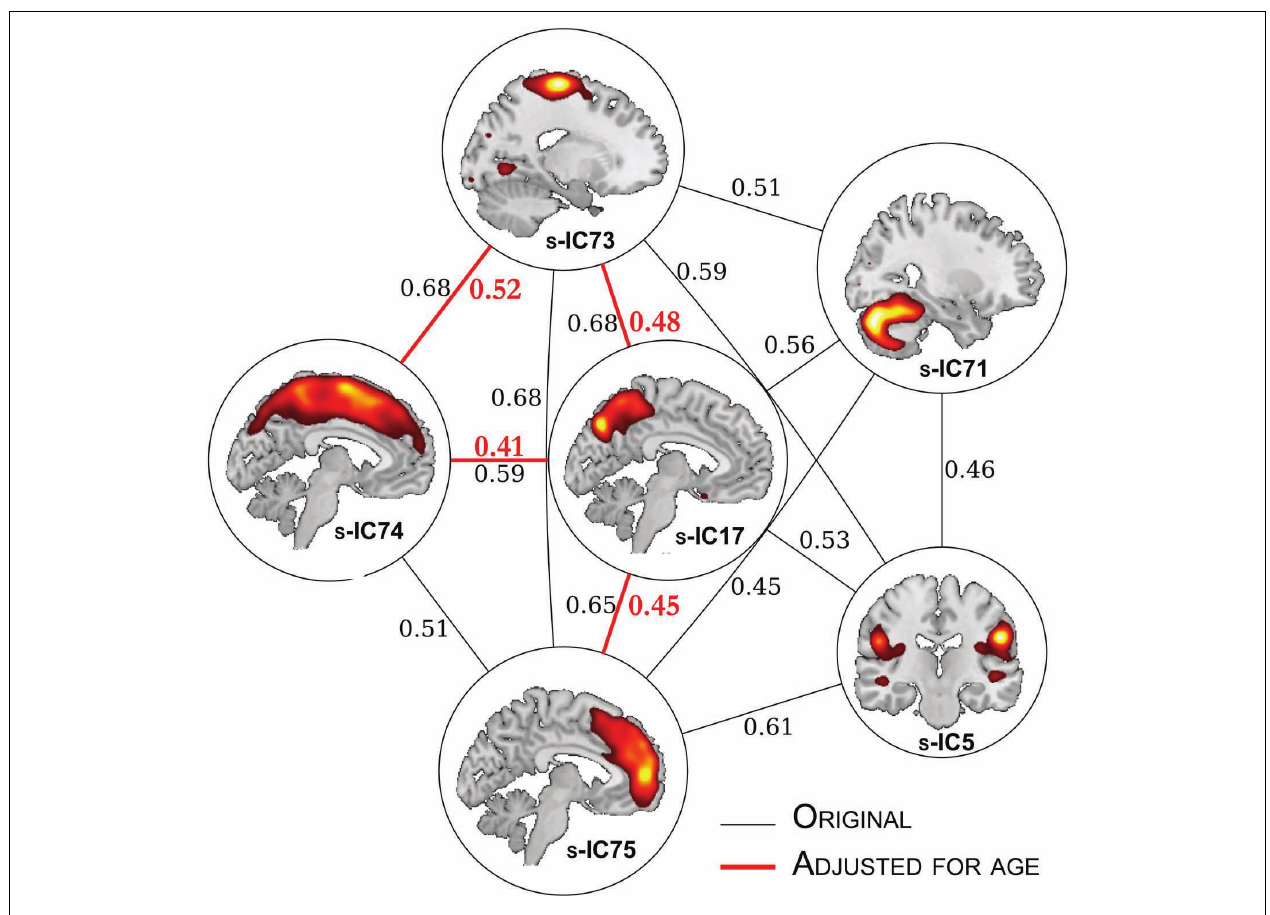
FIGURE 7 | Structural network correlations. The SNC results for component pairs that are r < 0.4.The edges in red refer to components pairs that survived age adjustment.The correlation coefficient values are adjacent to the edges.